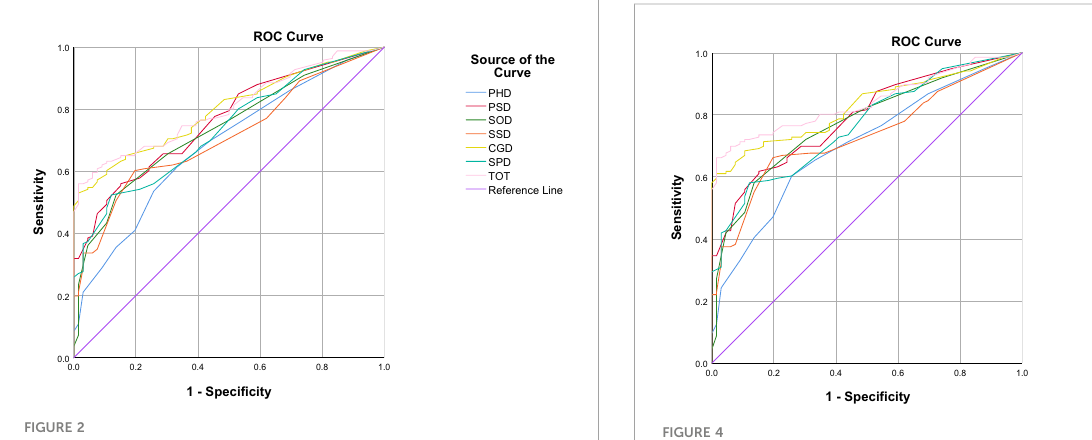
FIGURE 4 ROC curves of various domains under the Standard D.